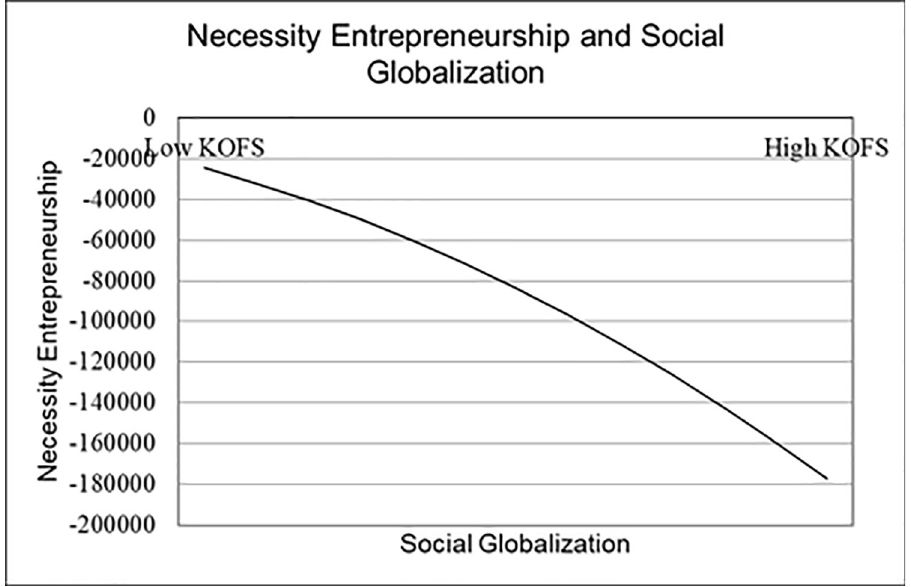
Fig 6. Quadratic fit of necessity entrepreneurship and social